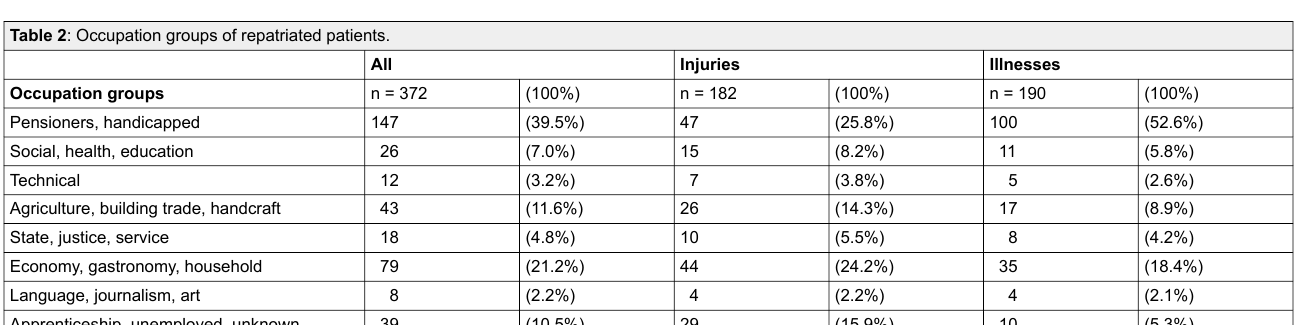
Table 2 : Occupation groups of repatriated